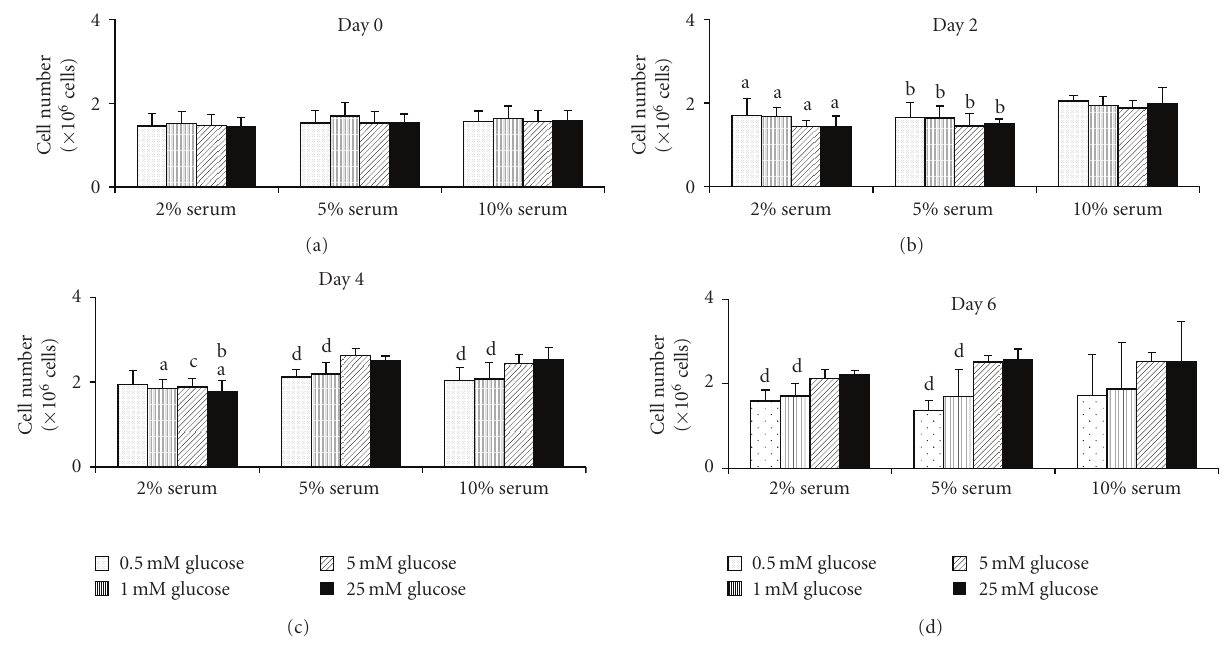
Figure 1: Cell population (mean ± standard deviation) over the course of six days while in two-dimensional culture ( n = 12 per group). Higher glucose and serum concentrations appear to produce higher cell populations over time. (a: significance between corresponding value in the 5% group; b: significance between corresponding value in the 10% group; c: significance between corresponding values in the 5% and 10% groups; d: significantly di ff erence between the 5.0 and 25.0mM glucose values within the same serum group; P = . 05).